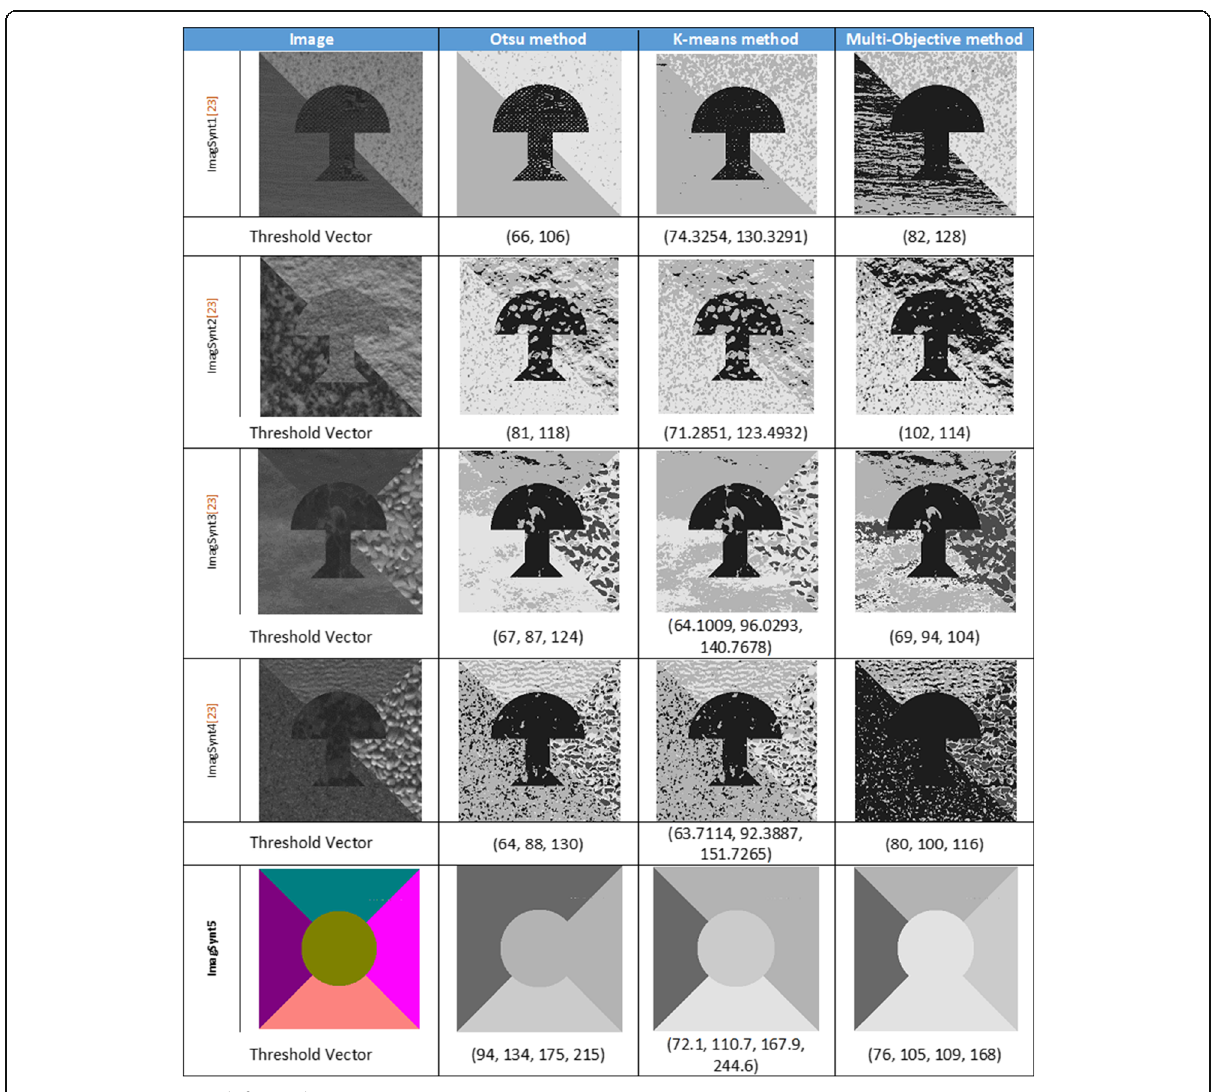
Fig. 4 Segmentation result for synthetic